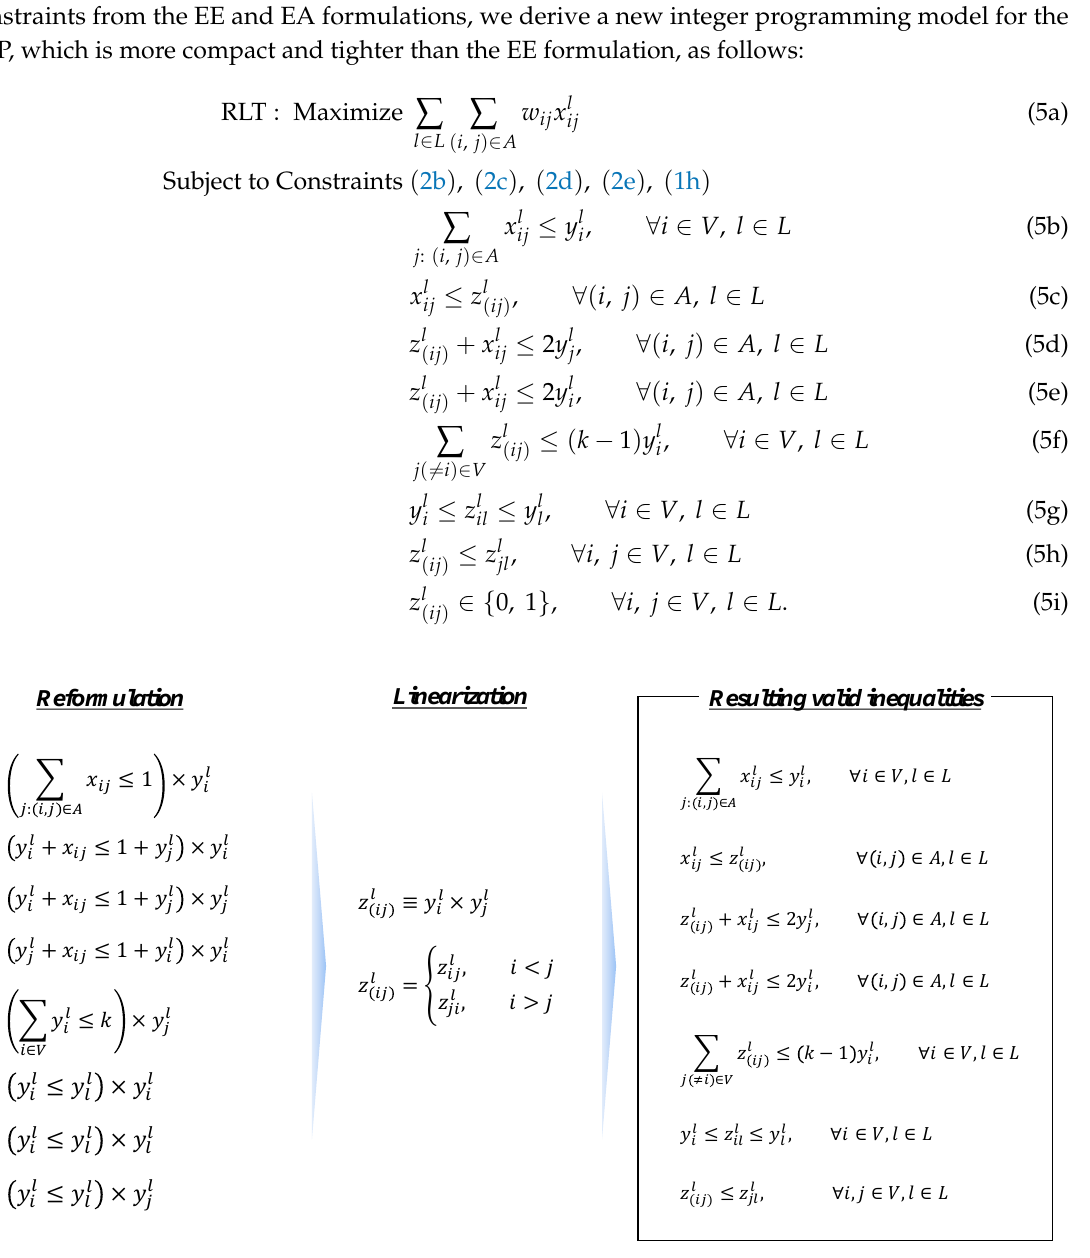
Figure 4. Illustration of the reformulation-linearization technique (RLT) for deriving new valid